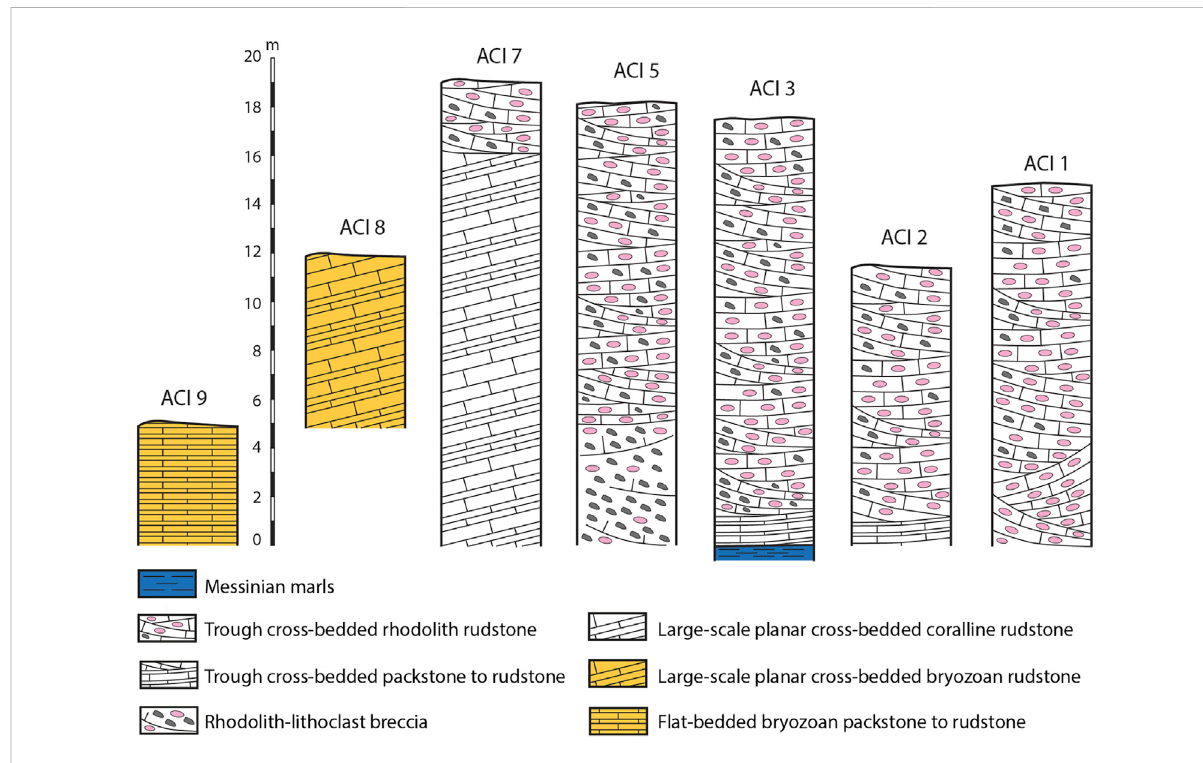
FIGURE 2 Representative columns of study sections (see Figure 1B for